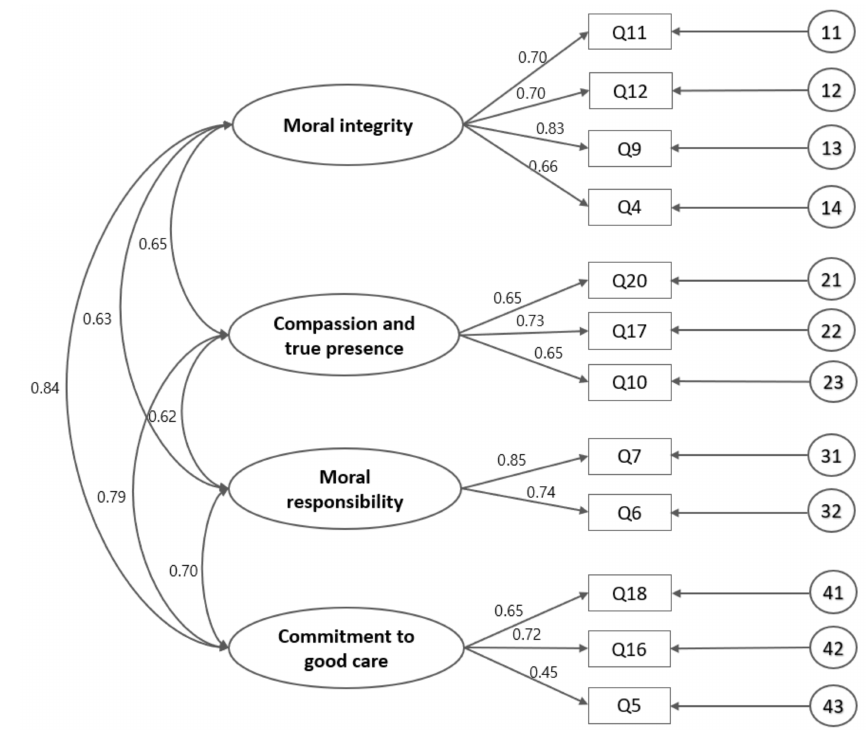
Figure 1. K-NMCS’s confirmatory factor analysis.